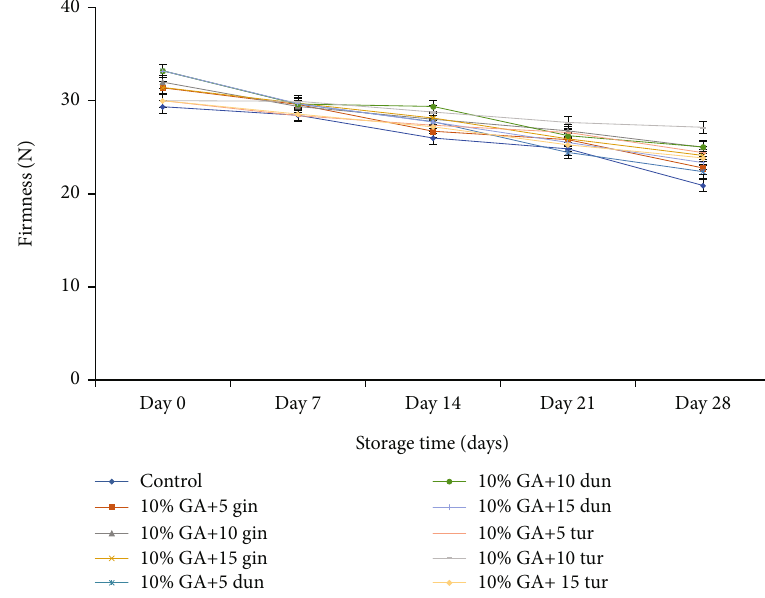
Figure 7: E ff ect of 10% GA incorporated with plant extracts at di ff erent concentrations on fi rmness (N) during cold storage for 28